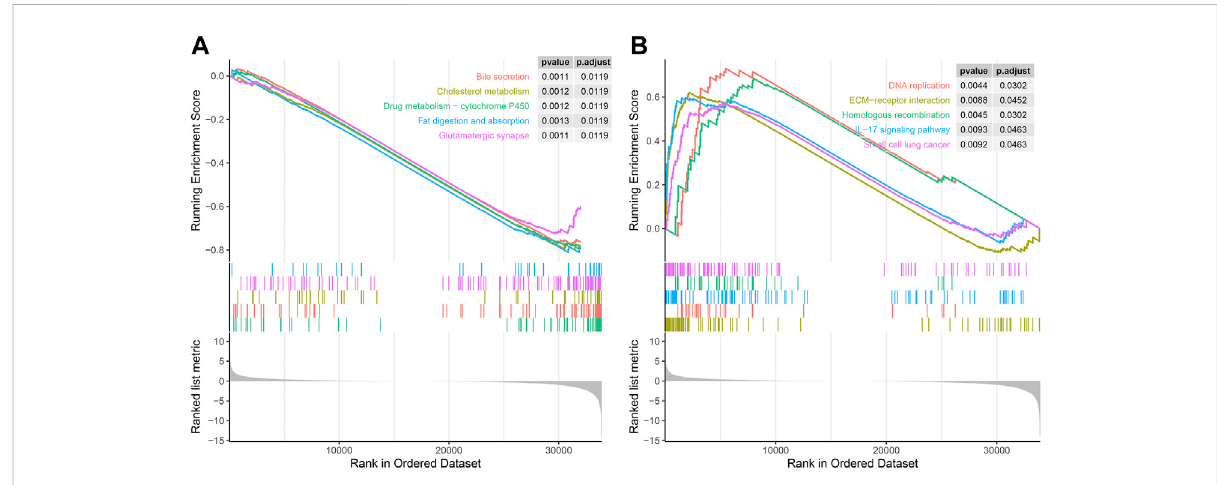
FIGURE 9 GSEA of SERPINH1. (A) Enrichment analysis in the high SERPINH1 expression group. (B) Enrichment analysis in the low SERPINH1 expression